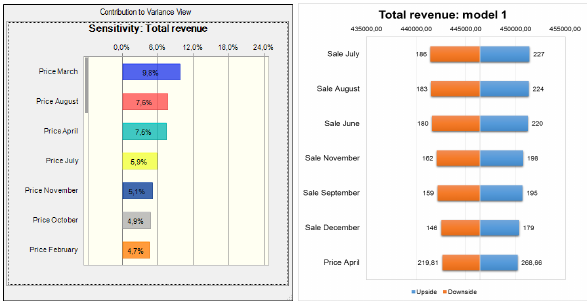
Figure 9: Sensitivity chart and tornado chart for total revenue per year: model 1.